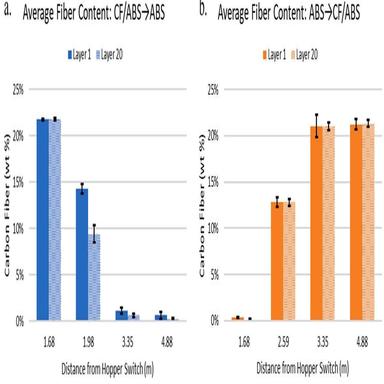
Measurements were taken for each of three prints and averaged for each location. The average fiber content for layers one and 20 are compared for both a. the CF/ABS to ABS transition and b. the ABS to CF/ABS transition.